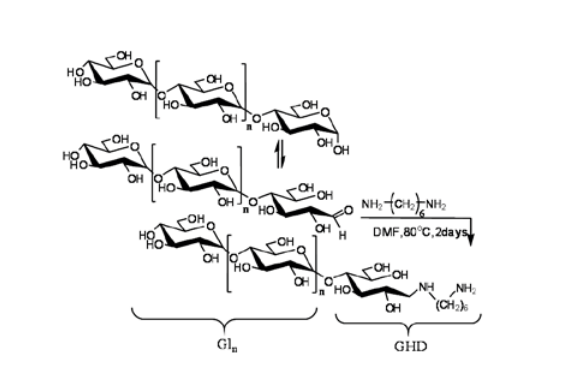
Figure 1. Synthesis of HMD-linked polysaccharides: reductive amination of maltodextrin with HMD and sodium cyanoborohydride as reducing